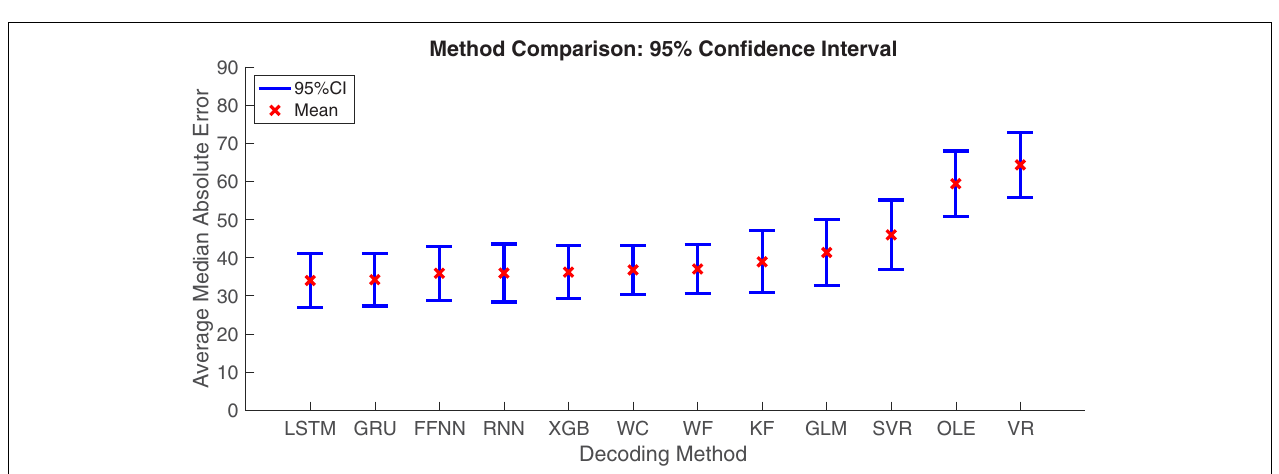
FIGURE 8 | Mean ± 95% Confidence-Interval (CI) Median Absolute Error (MAE) for each decoding method. Data from different brain regions and datasets were pooled. KF, Kalman Filter; GLM, Generalized Linear Model; VR, Vector Reconstruction; OLE, Optimal Linear Estimator; WF, Wiener Filter; WC, Wiener Cascade; SVR, Support Vector Regression; XGB, XGBoost; FFNN, Feedforward Neural Network; RNN, Recurrent Neural Network; GRU, Gated Recurrent Unit; LSTM, Long Short-Term Memory.